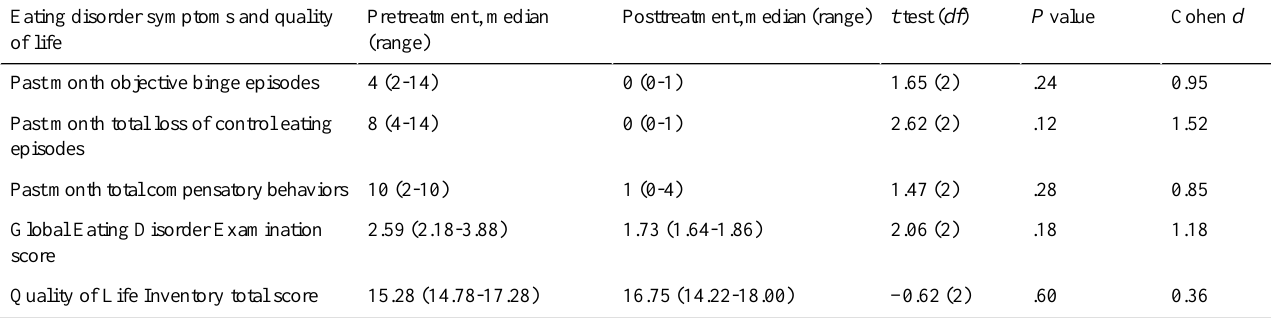
Table 3. Change in eating disorder symptoms and quality of life from pre- to